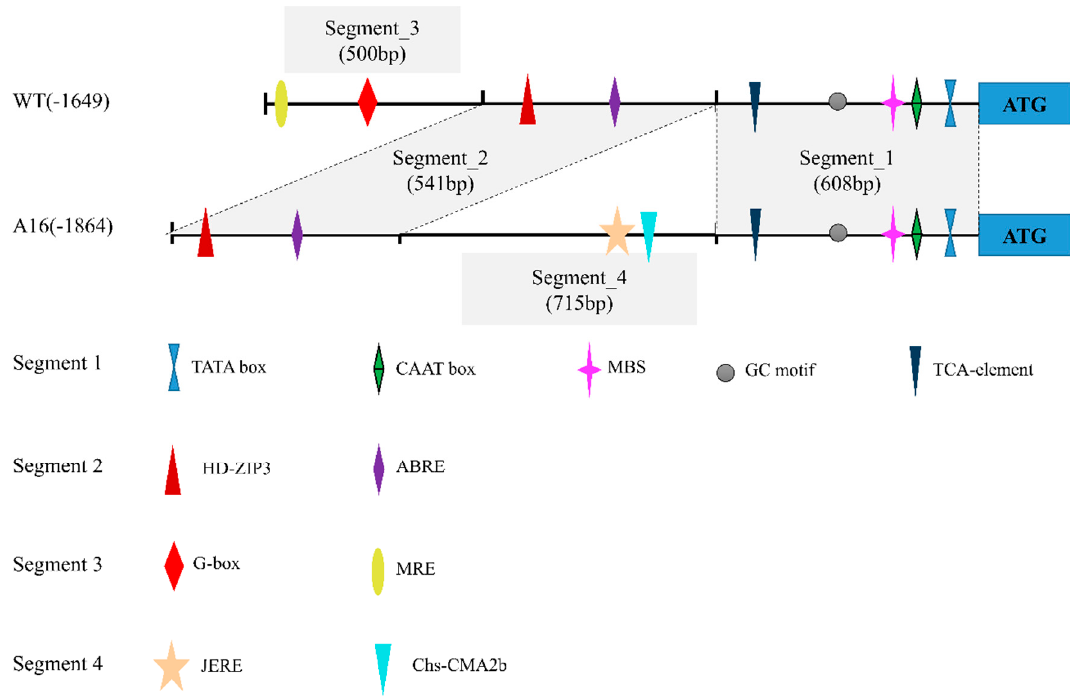
Figure 1. PpDXS1 promoter from P. pratensis wild-type (WT) and dwarf mutant (A16). Putative cis elements are labeled as shown. Element positions are shown proportional to the full length of the promoter. The common segment of promoter regions in WT and A16 are shaded.